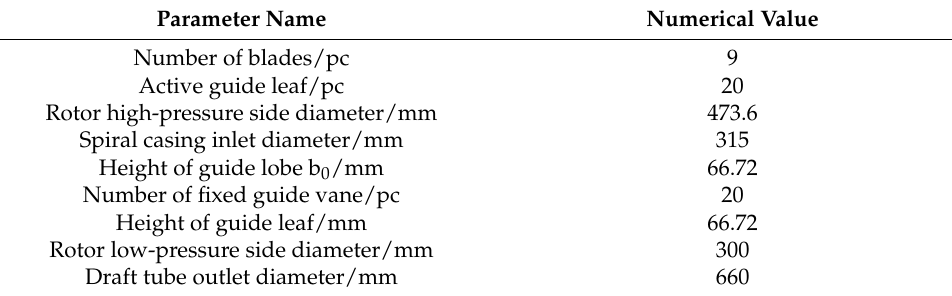
Table 2. Geometric parameters of model pump turbine.